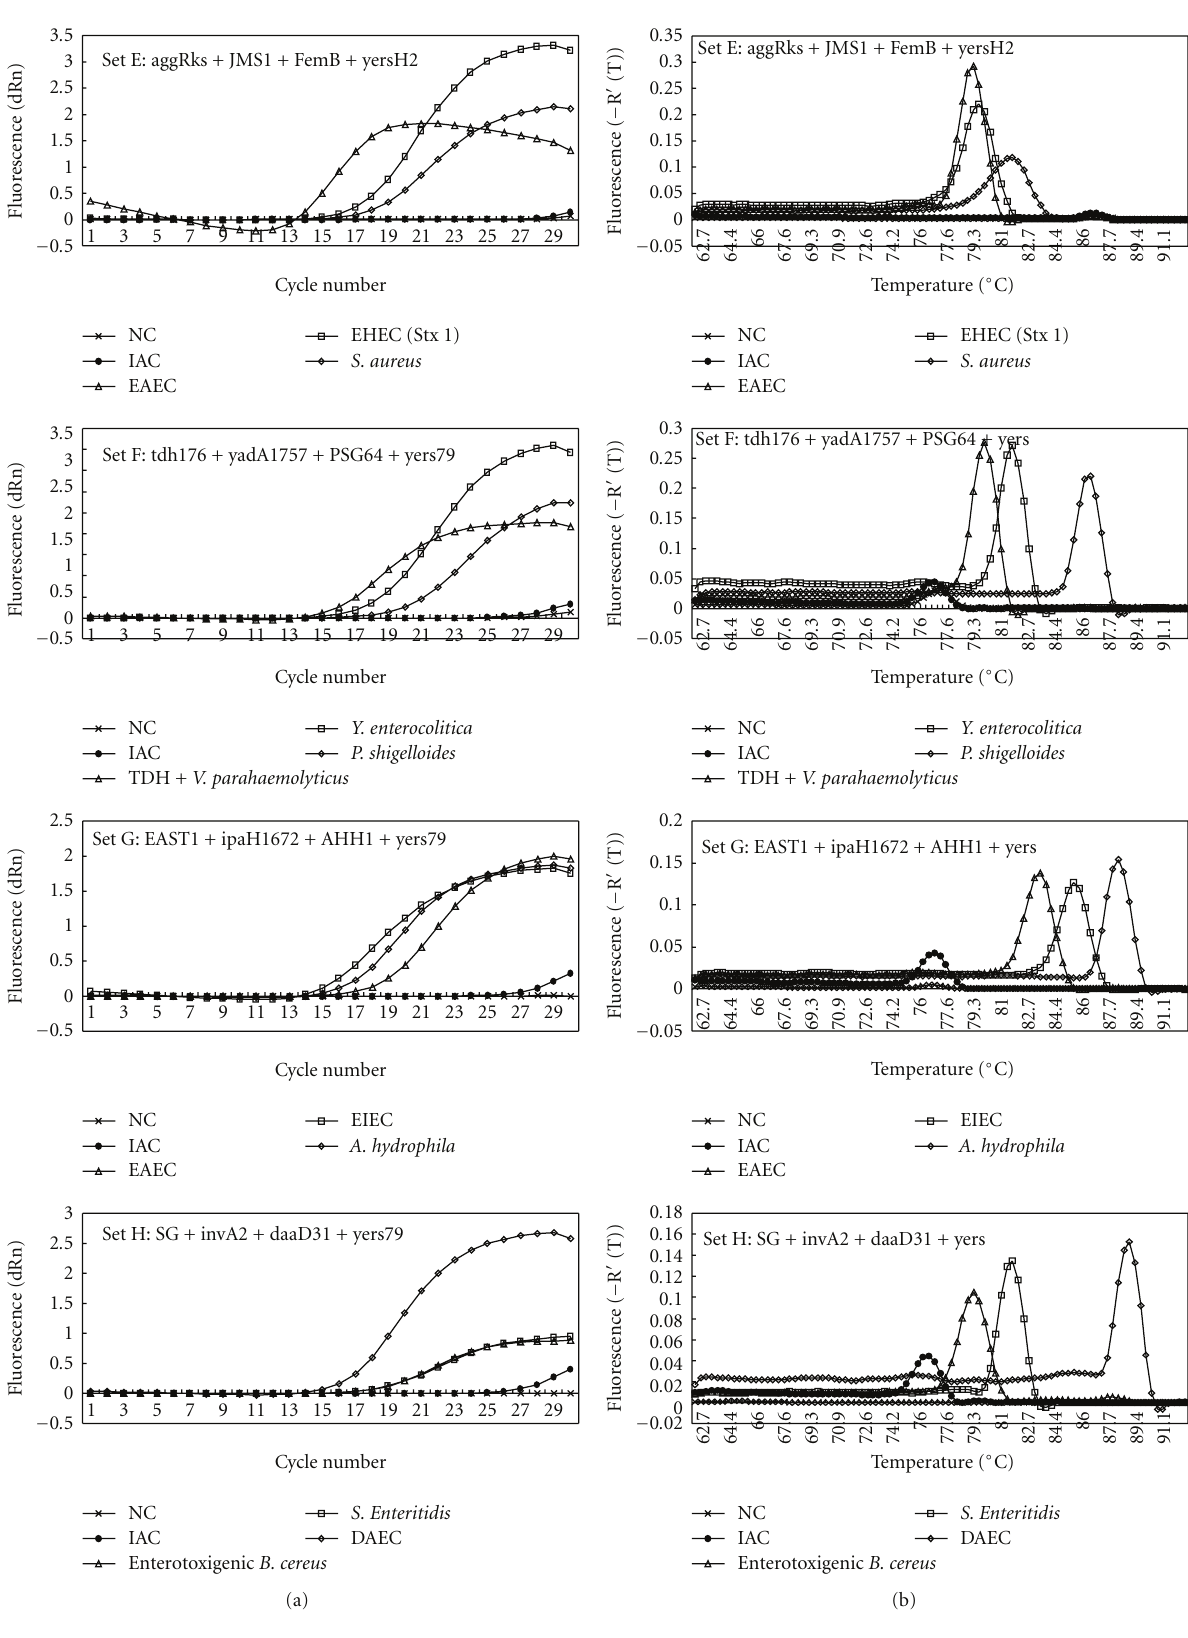
Figure 1: Amplification (a) and melting curve analysis (b) of 3 target genes of foodborne pathogens and IAC gene by primer sets A to H in multiplex real-time